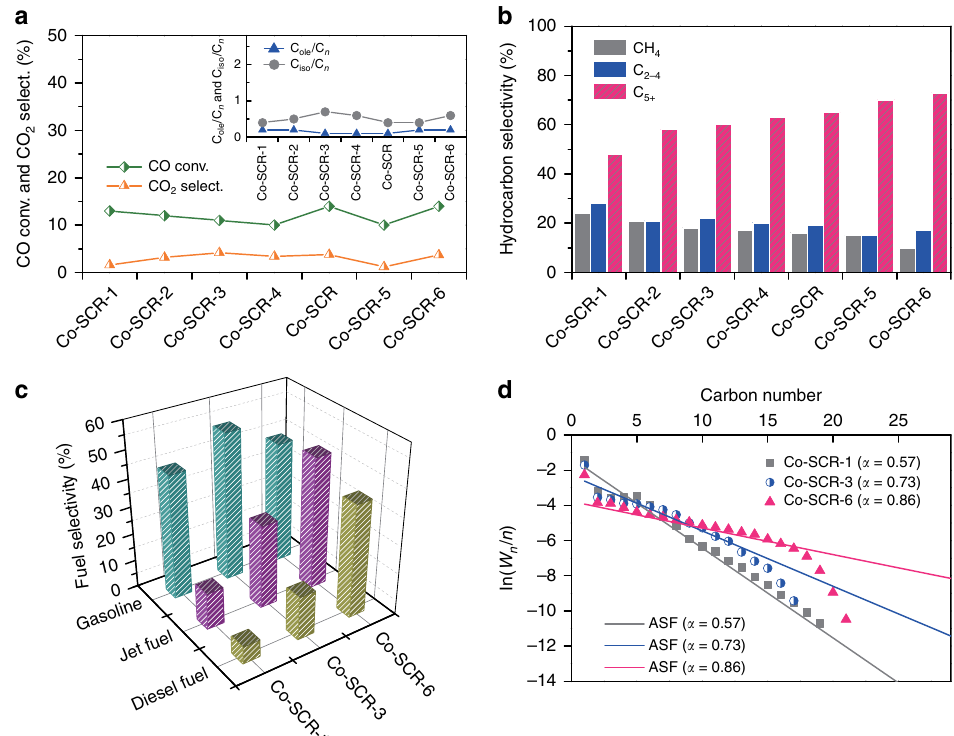
Fig. 4 Impact of geometrical structures on FT product distribution. a CO conversion, C ole /C n ratio and C iso /C n ratio of the Co-SCRs. b Hydrocarbon distribution of the Co-SCRs. c Fuel selectivity of gasoline (C 5 – 11 ), jet fuel (C 8 – 16 ), and diesel fuel (C 10 – 20 ) for the Co-SCR-1, Co-SCR-3, and Co-SCR-6. d Chain growth probability ( α ) of the Co-SCRs. The α value was calculated based on the growth trend of hydrocarbons C 5 – 11 over the Co-SCR-1, Co-SCR-3, and Co-SCR-6, respectively. The calculation rule of the α value was according to the Anderson – Schulz – Flory model 63,64 . Reaction conditions: T = 533 K; P